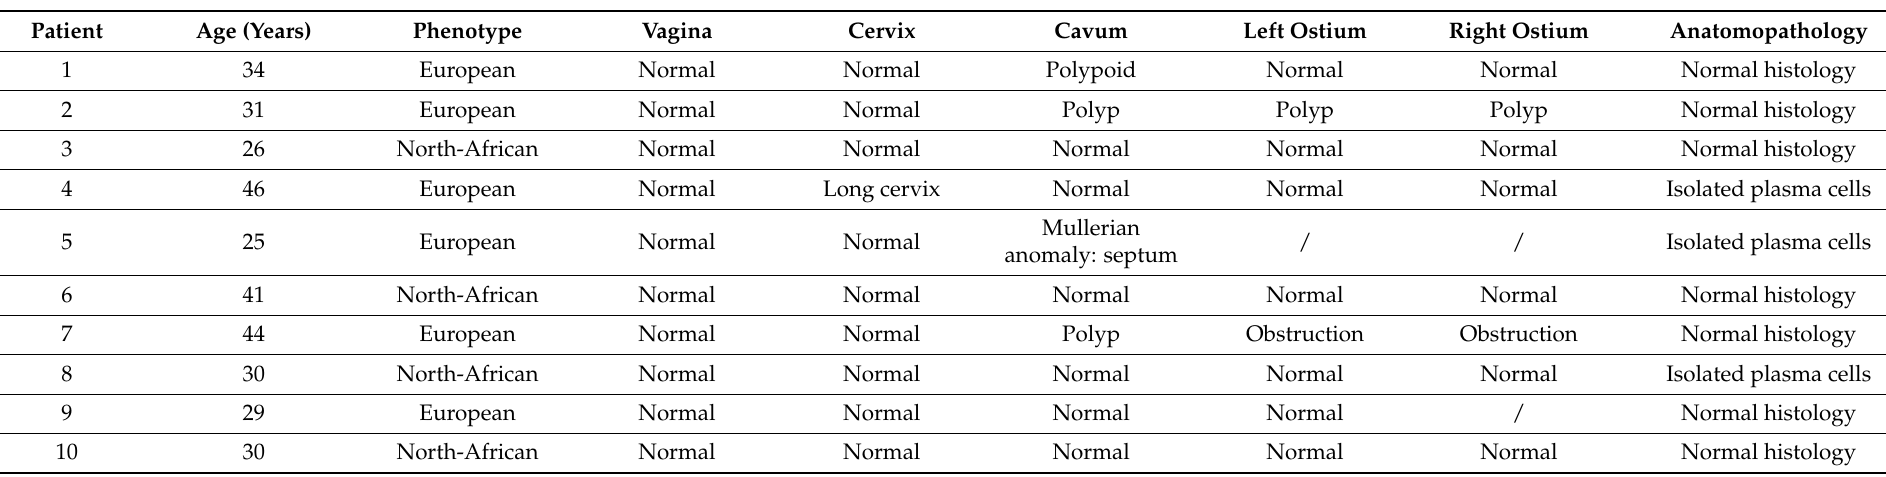
Table 1. Clinical data from the 10 patients enrolled in the study. Observations of the vagina, cervix, cavum and ostium were documented in the context of their fertility traject. From every patient, a biopsy was analyzed in the laboratory of anatomopathology for the presence of plasma cells indicating